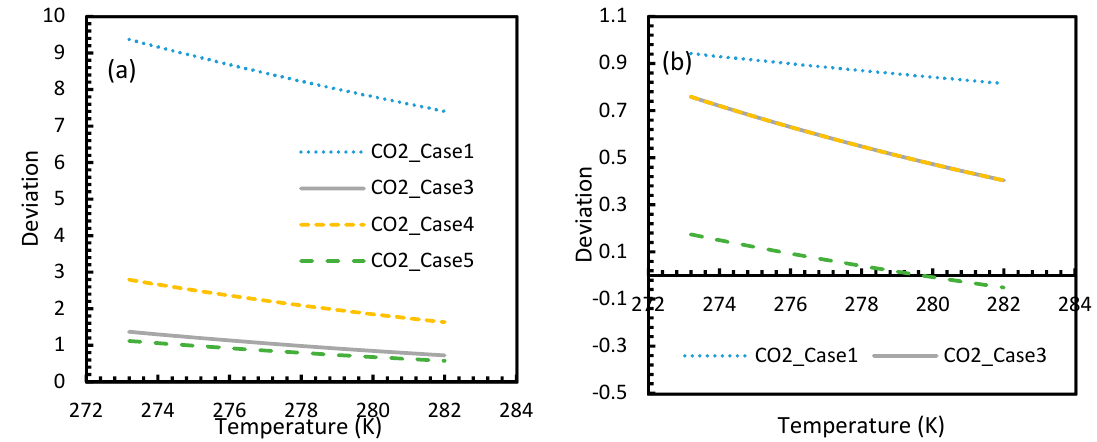
Figure 10. Profiles of nucleation rate deviations of CO 2 ( a ) and CH 4 ( b ) under isobaric conditions at a reference pressure 30 MPa, calculated through the considered cases apart from Case 6, from Case 2. The profiles are the same as the profiles shown in dissolved concentration profiles. Molecules 2018 , 23 , x FOR PEER REVIEW 16 of 28 1E+001E+021E+041E+061E+081E+101E+121E+141E+161E+181E+201E+221E+24